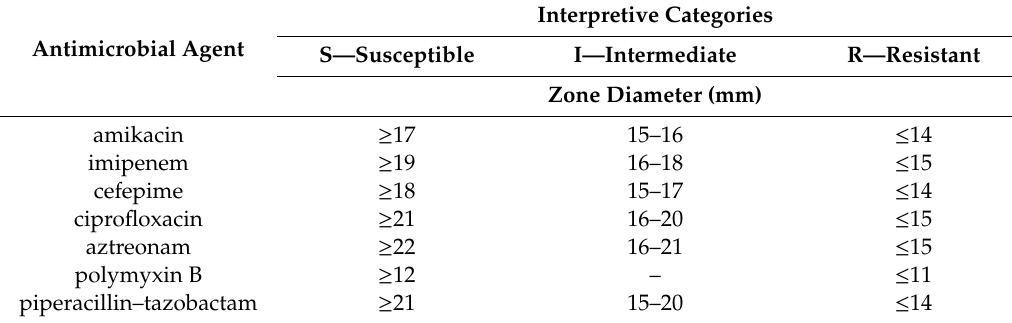
Table 1. Criteria for assessing Pseudomonas aeruginosa sensitivity to antimicrobial agents according to CLSI guidelines